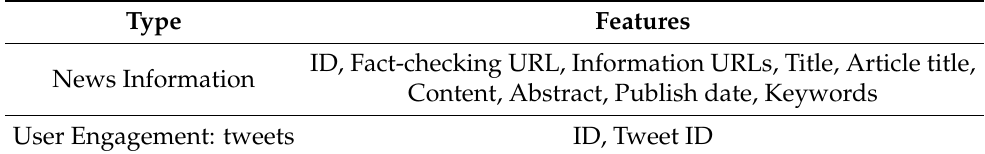
Table 1. Feature descriptions of the news table and user engagement in the CoAID